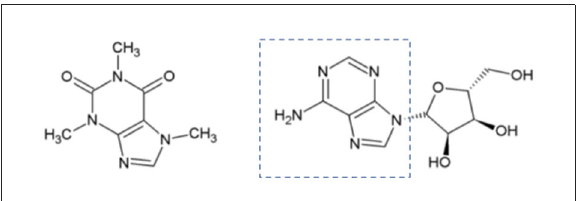
FIGURE1 Chemical structures of caffeine (left) and adenosine